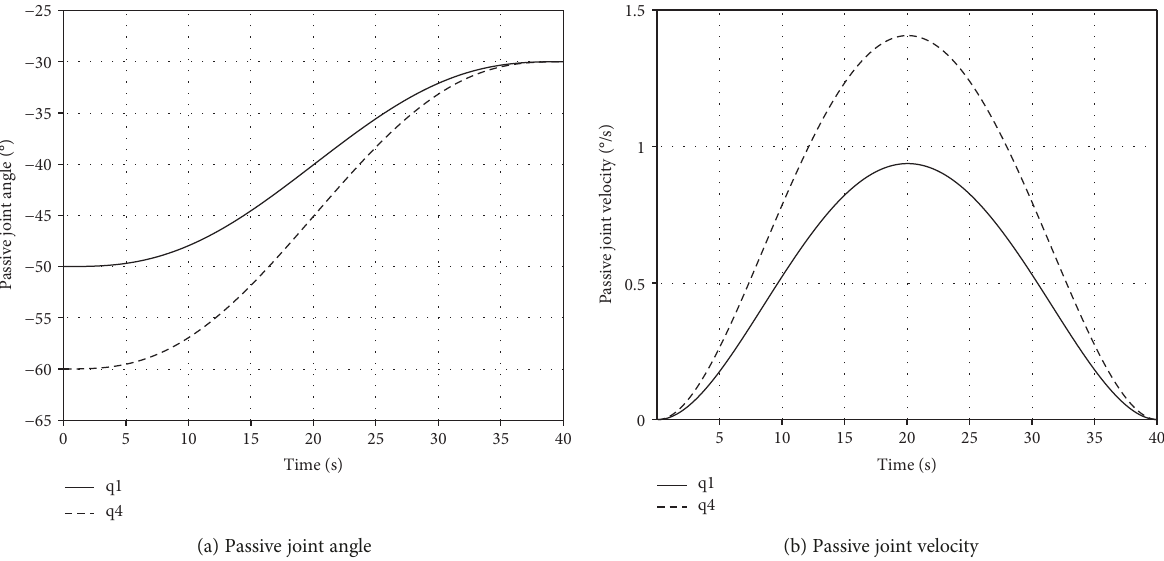
Figure 6: The variations of passive joint angle and velocity with execution of the passive joint regulating